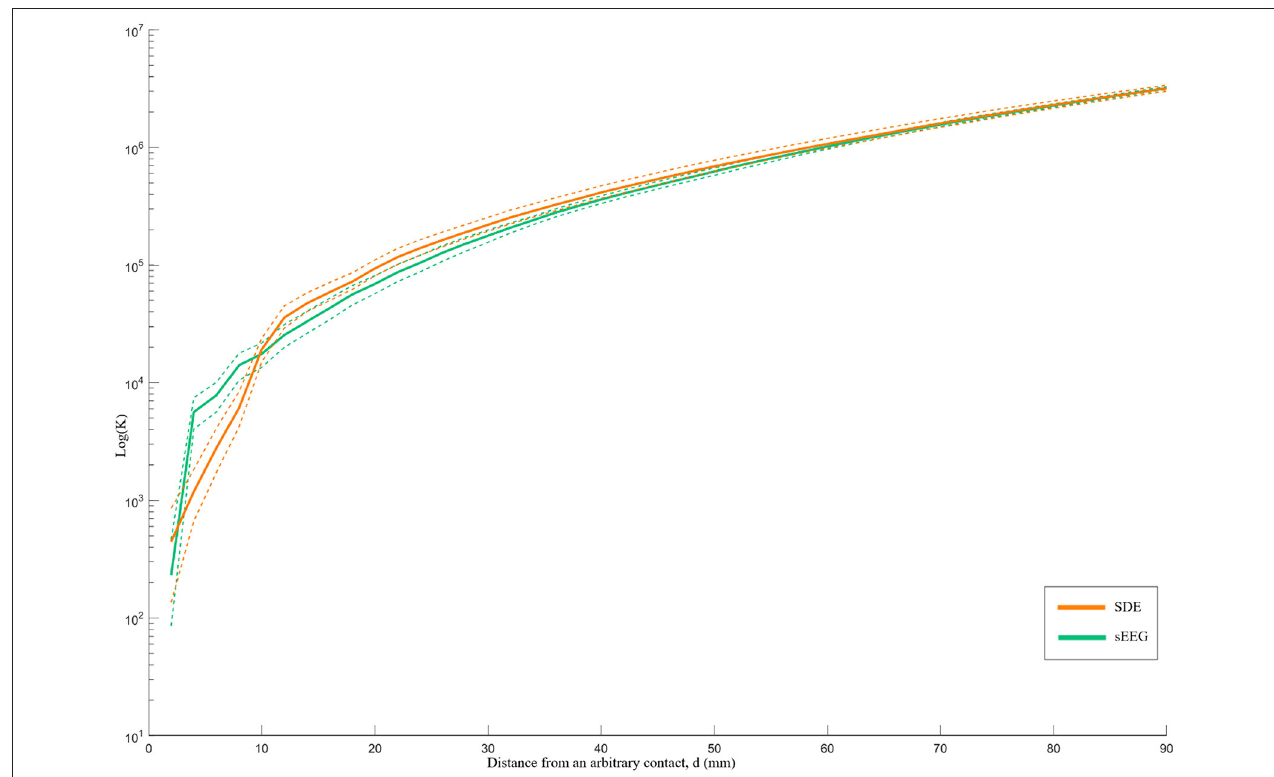
FIGURE 3 | Ripley’s k-function for SEEG and SDE over distance d . The Y-axis represents the K-function values on a logarithmic scale, while the X-axis represents the distance from an arbitrary contact in millimeters. The dashed lines represent the 95% confidence intervals of the k-function values. SEEG implants had denser coverage than SDE over distances < 10mm and sparser coverage than SDE over distances >